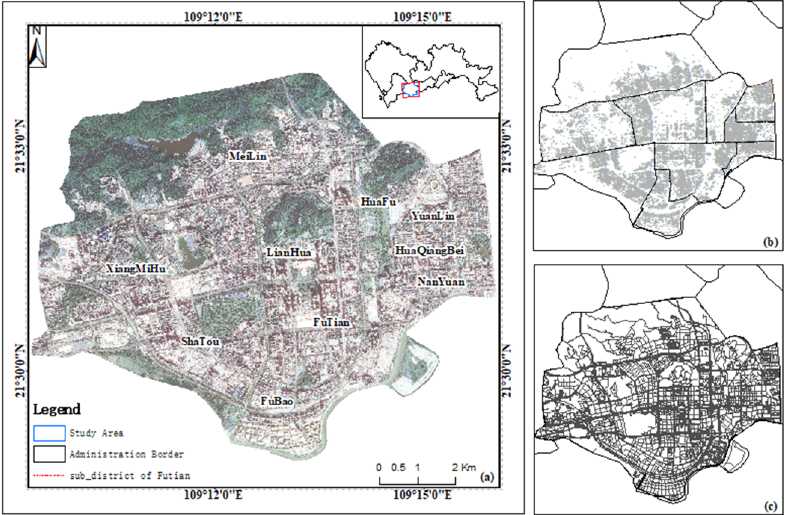
Figure 4. ( a ) High-resolution images from GaoFen-1 (GF-1) covering Futian District; ( b ) location of Shenzhen in China; ( c ) POIs of Futian District.